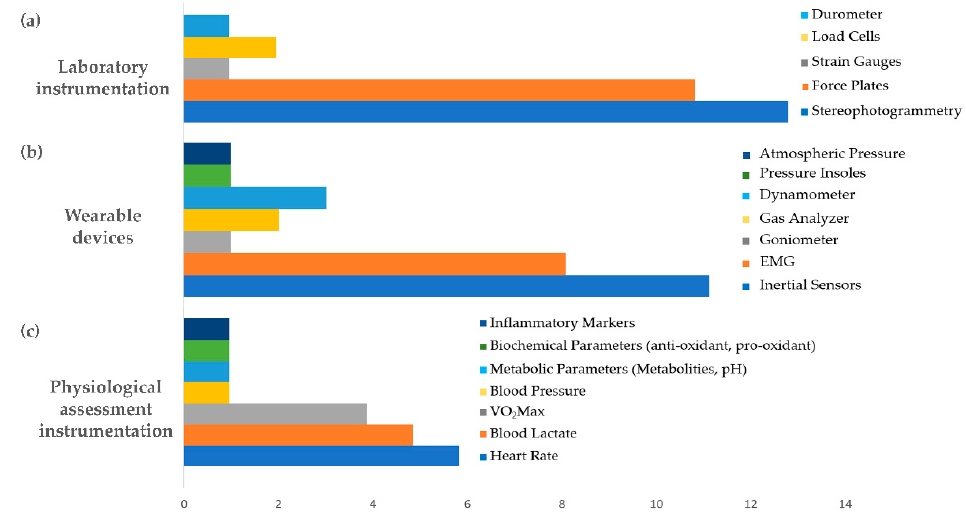
Figure 10. Laboratory ( a ) and wearable ( b ) instrumentation for motion analysis, and instruments for physiological assessment ( c ): occurrence of instruments and parameters in reviewed articles reporting on their use for assessing overuse-related injuries.